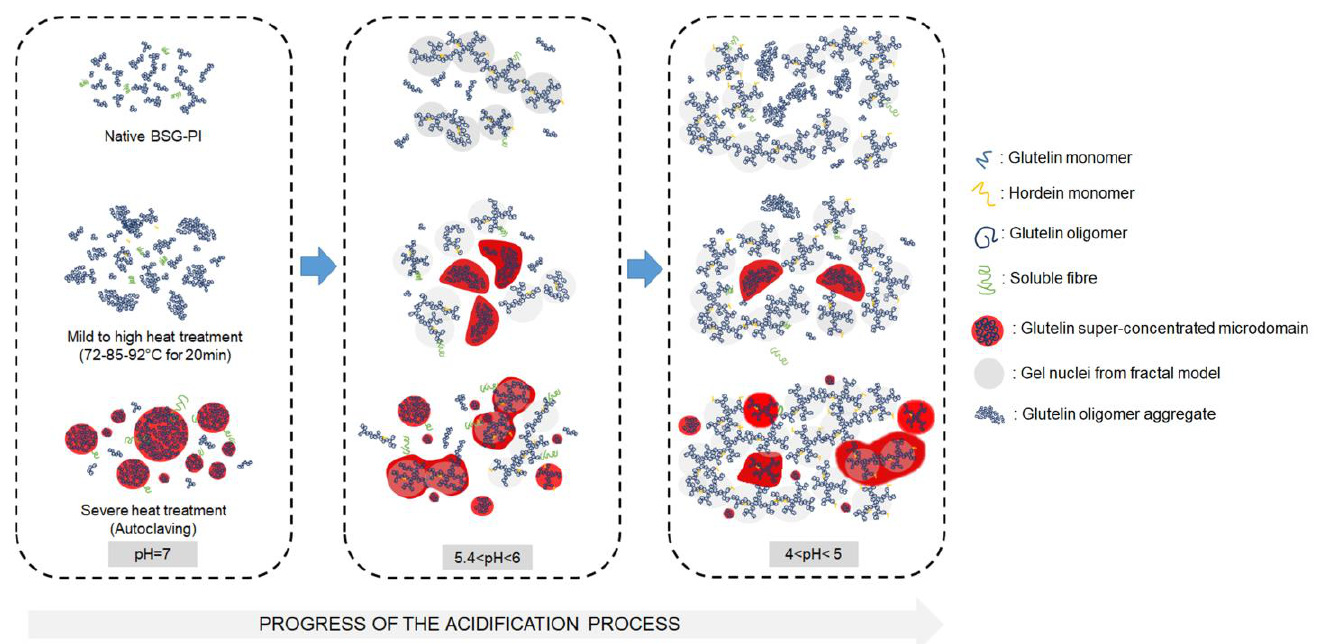
Figure 3. With permission of Elsevier. BSG-PI = Brewers spent grain protein isolate. Figure 3. Semisolid gels can be formed from proteins found in brewers spent grains via an acid- induced gelation route. Heat-treatment of proteins before gelation results in glutelin-rich mi- crodomains that alter the structural properties of the gel. Image adapted from Hellebois et al. [78] with permission of Elsevier. BSG-PI = Brewers spent grain protein